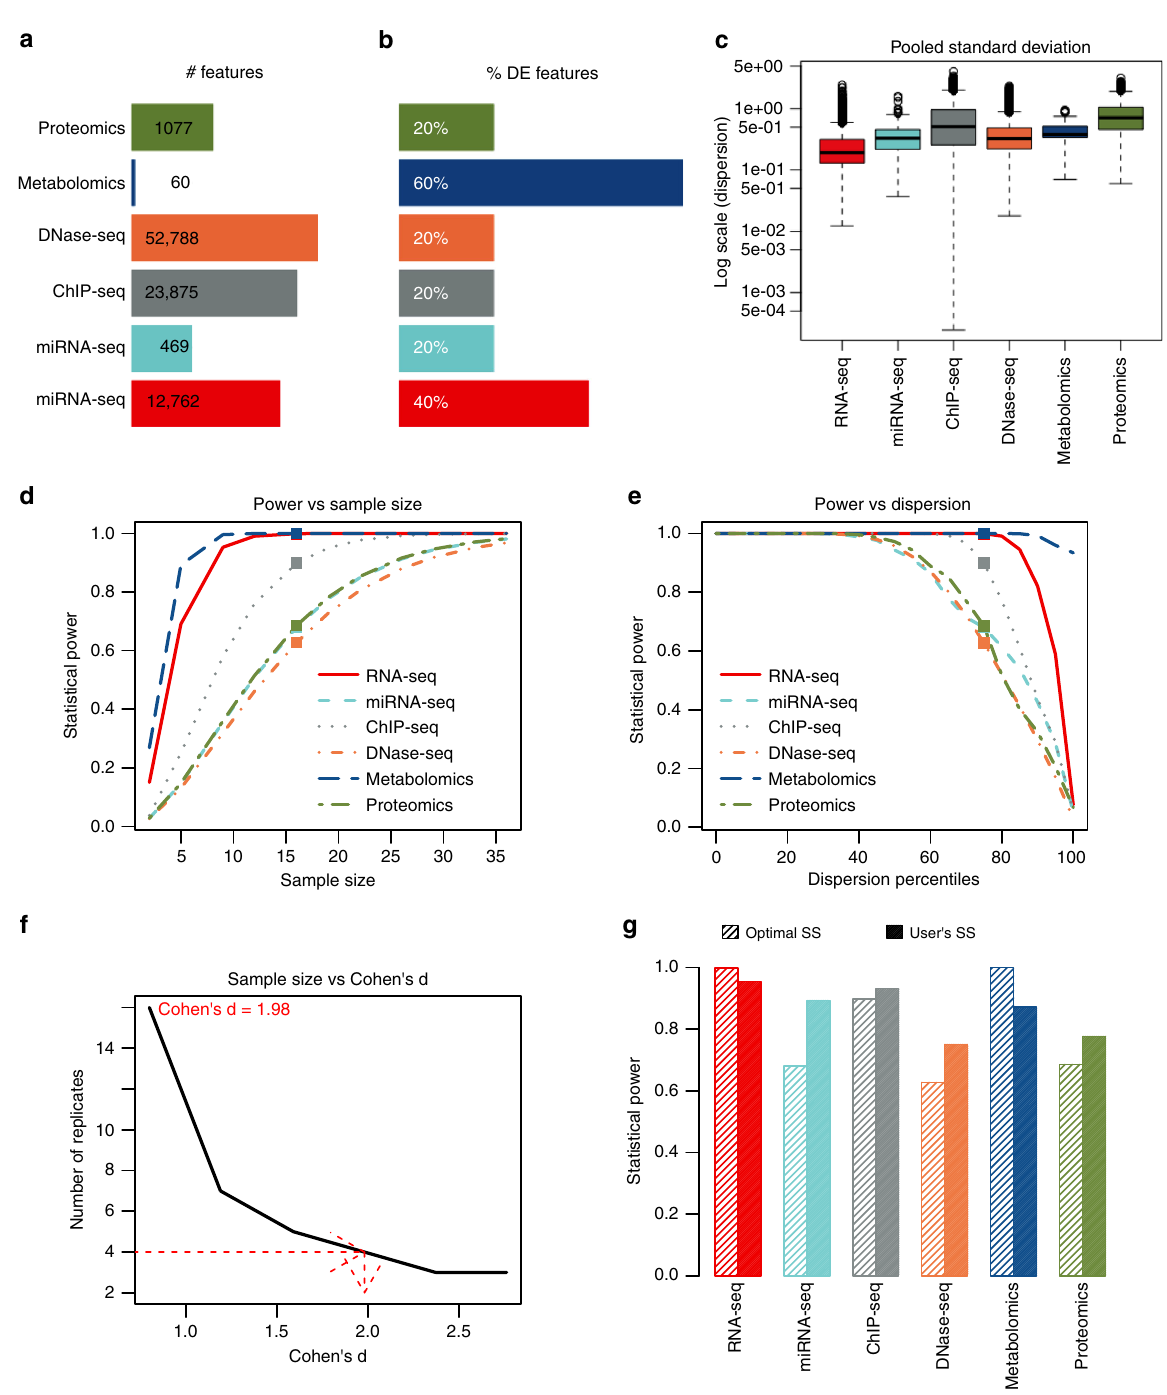
Fig. 4 MultiPower application to STATegra data. a – c Pilot data analysis. Each color represents a different omic data type. a Number of features per omic. b Expected percentage of differentially expressed (DE) features for each omic. c Pooled standard deviation (PSD) per gene and per omic for the estimated DE features (pseudo-DE features, see “ Methods ” section for details). Boxplots represent the median and interquartile range (IQR). Whiskers depict the minimum and maximum of data without outliers, which are the values outside the interval (Q1 − 1.5 × IQR, Q3 + 1.5 × IQR). d – g MultiPower results with parameters same sample size in all the omics, minimum power per omic = 0.6, minimum average power = 0.8, FDR = 0.05, initial Cohen ’ s d = 0.8. d Statistical power curves for each omic for sample sizes between 2 and 35. Squared dots indicate power at the optimal sample size ( n = 16). e Statistical power curves for each omic when considering different percentiles of PSD. Squared dots indicate power for the dispersion used in power calculations for each omic (75th percentile). f Curve relating the initial Cohen ’ s d to the optimal sample size needed to detect each magnitude of change. For the speci fi ed sample size ( n = 4), the red arrows and text highlight the magnitude of change to be detected (Cohen ’ s d = 1.98 in this case). g Statistical power per omic using the optimal sample size ( n = 16) with Cohen ’ s d = 0.8, and the maximum sample size allowed by the user ( n = 4) with Cohen ’ s d =